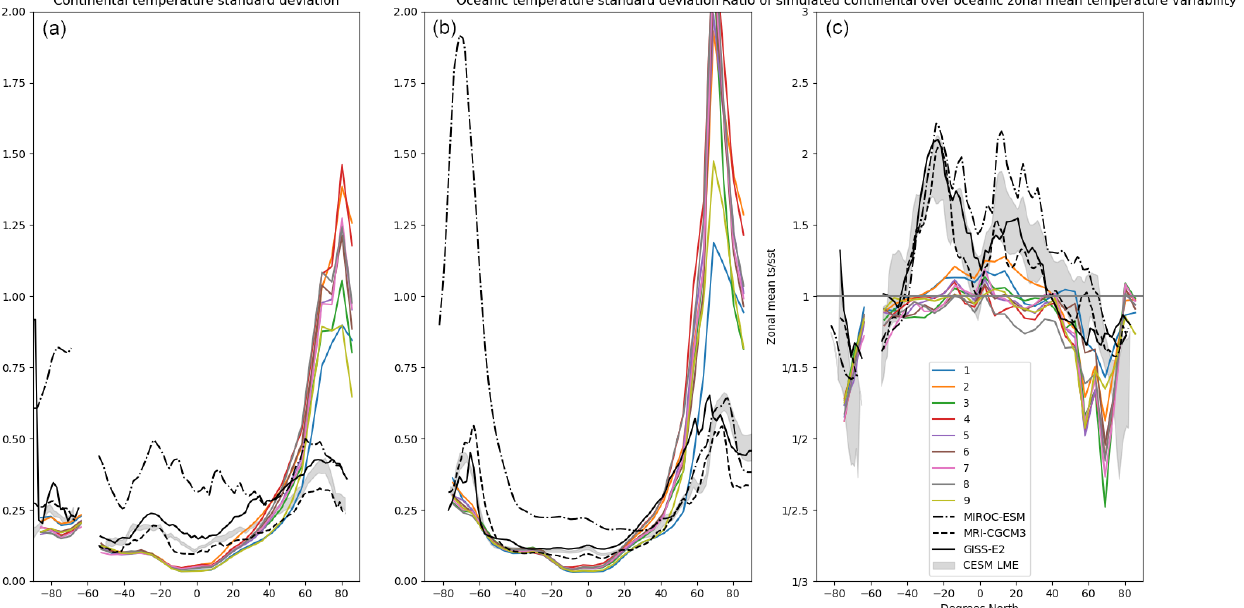
Figure A7. Simulated zonally averaged contrast in land–ocean temperature variability as a function of latitude. Depicted are continental variability (a) , ocean variability (b) and the ratio of continental over ocean variability (c) . Atmospheric 2m temperatures over the oceans are used to calculate simulated ocean temperature variability. Results are shown for the nine-member perturbed-parameter i LOVECLIM ensemble (colours) and for three different CMIP5 simulations for the last 1000 years. Grey shading shows the 1 σ range of all CESM ensemble members. Note that the y -axis scale in (c) is non-linear, with for instance 1 / 1 . 5 or 1 / 2, meaning that there is 50% or 100% more variability over the ocean than there is over the